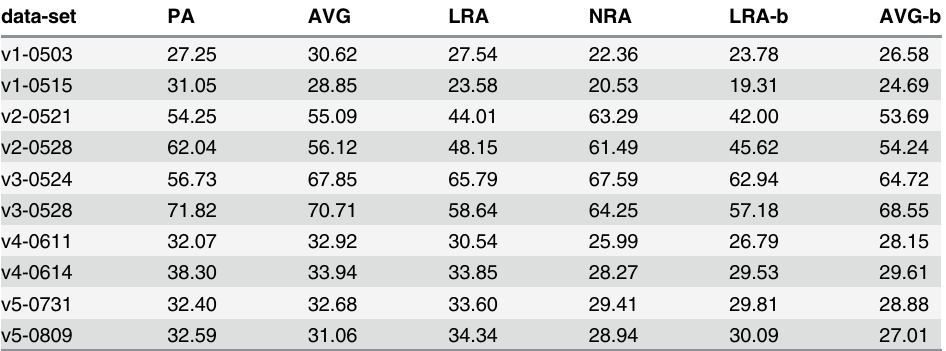
Table 1. Width of ADC histogram σ D for a selected single slice (and region of interest) from each data- set; methods include protocol A and the corresponding average slice using protocol B with and with- out motion correction; same units as ADC (10 − 5 mm 2 / s ).